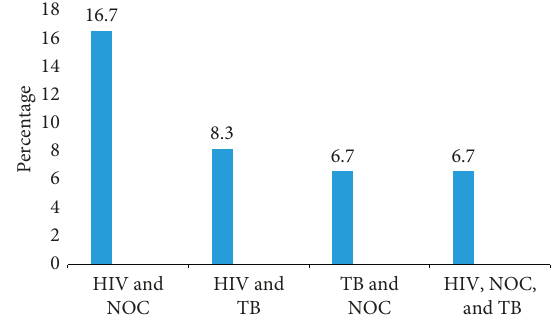
Figure 4: HIV, TB, and Nocardia spp. coinfection among study participants. NOC, Nocardia .